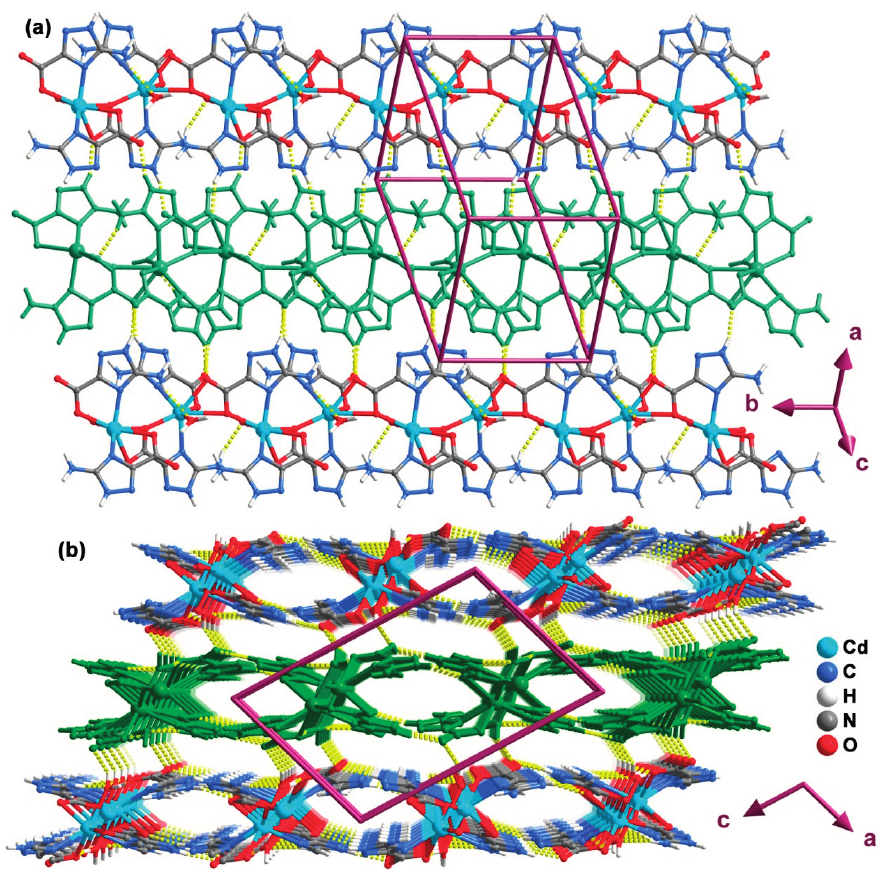
Figure 8. Ball-and-stick representation of the ( a ) 2D hydrogen-bonded network formed between adjacent 1D coordination chains (represented with alternating colors) and the ( b ) 3D hydrogen-bonded supramolecular network viewed in perspective along the [010] direction of the unit cell (layers represented with alternating colors) present in compound 4